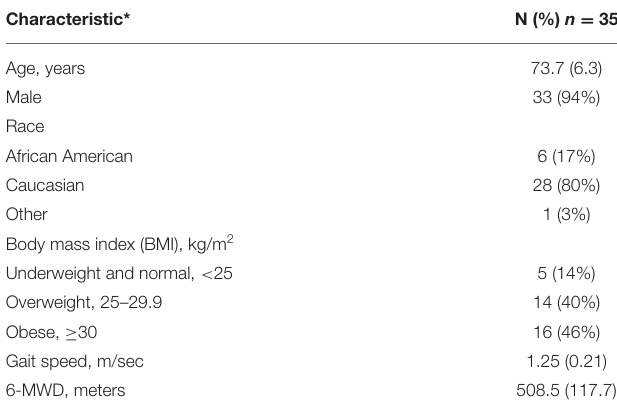
TABLE 1 | Description of the study